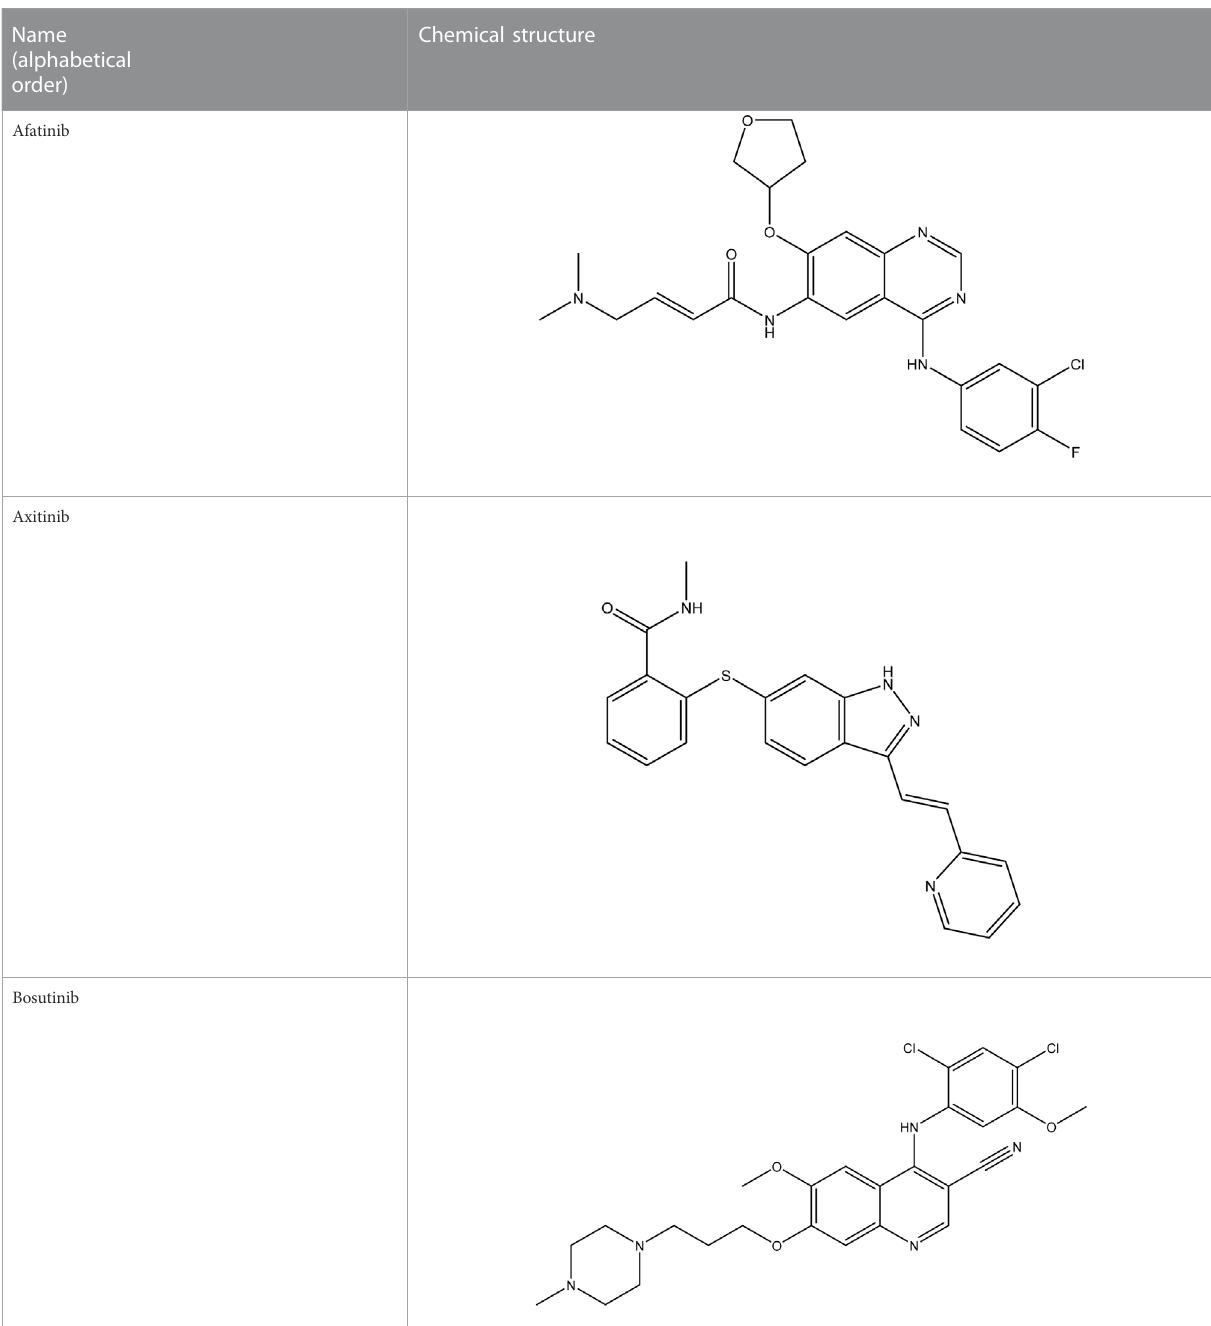
TABLE 1 Chemical structures of tyrosine kinase inhibitors used in